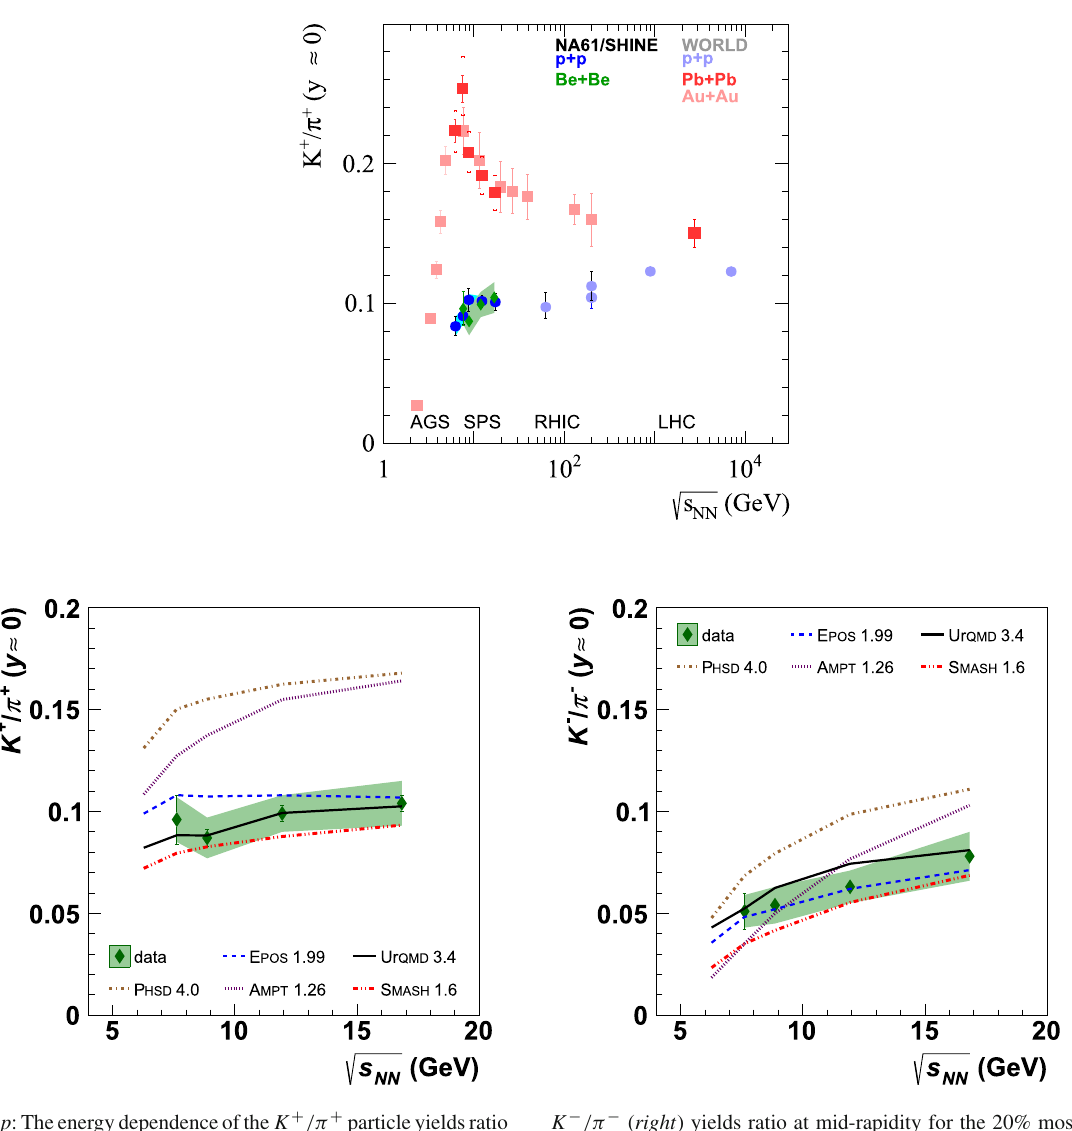
Fig. 3 Top :Theenergydependenceofthe K + /π + particleyieldsratio at mid-rapidity for the 20% most central Be+Be, central Pb+Pb and Au+Au collisions, as well as inelastic p+p interactions. Both statistical (vertical bars) and systematic uncertainties (shaded bands) are shown. Bottom : Comparison of the energy dependence of K + /π + ( left ) and